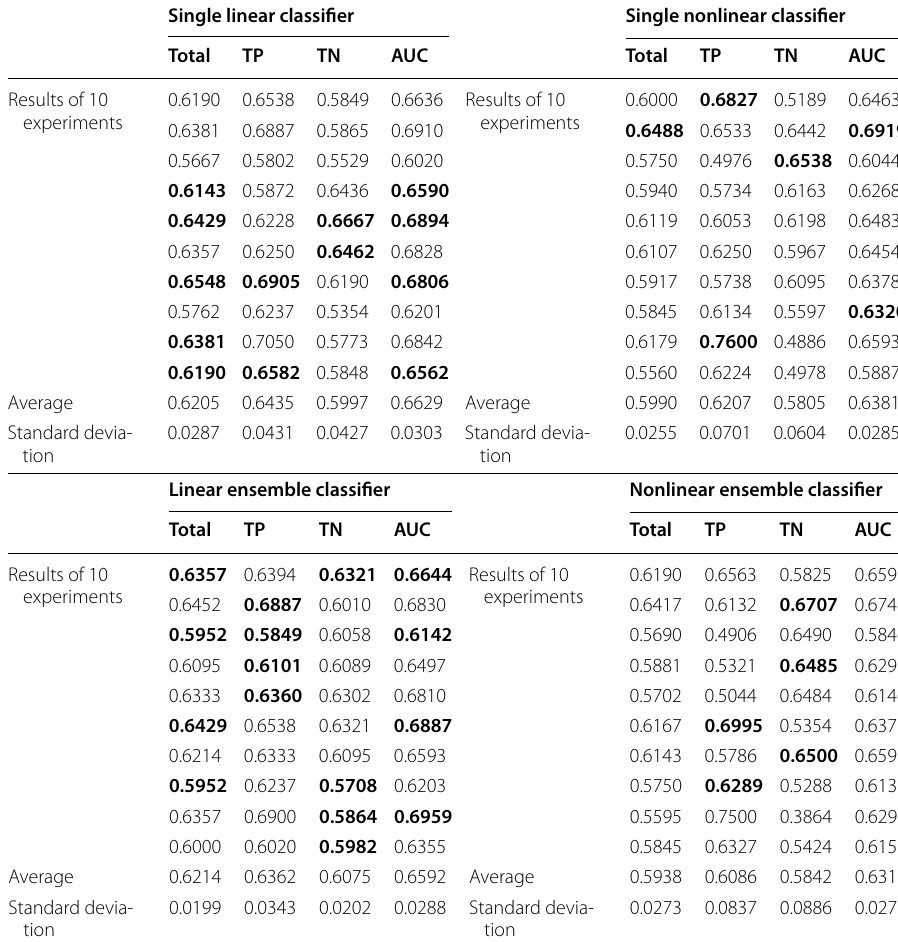
Table 7 Robustness analysis of classification without feature extraction in Kaggle dataset when feature dimensions sample ≥